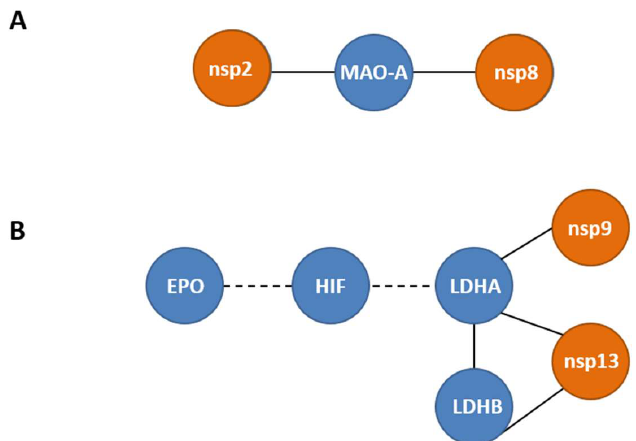
Figure 14. PPI sub-networks between ( Α ) MAOA and SARS-CoV-2 non-structural proteins nsp2 and nsp8. ( Β ) PPI sub-networks between, LDHA and LDHB and the viral nsp9 and nsp13 proteins. Dashed lines depict the transcriptional regulation of LDHA and EPO genes by the HIF transcription